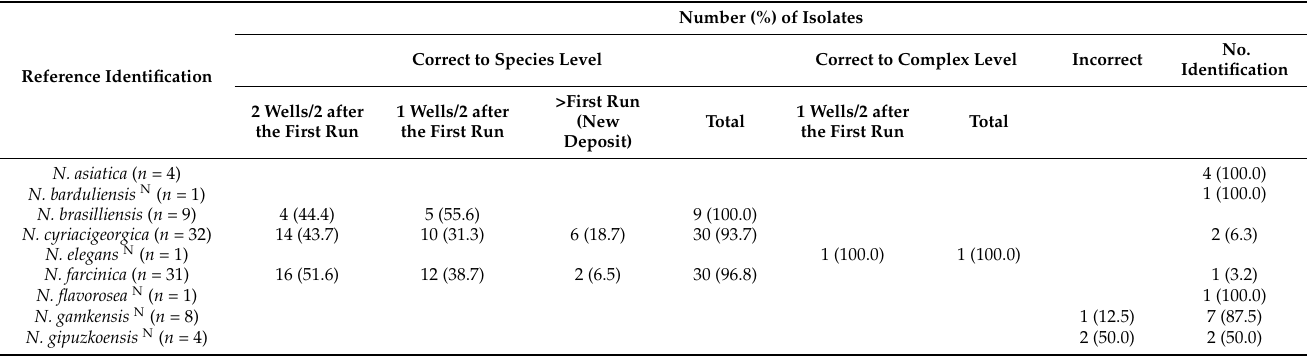
Table 1. Accuracy of Nocardia identification between VITEK-MS V3.2 results and identification based on 16S rRNA and hsp65 gene sequencing (reference